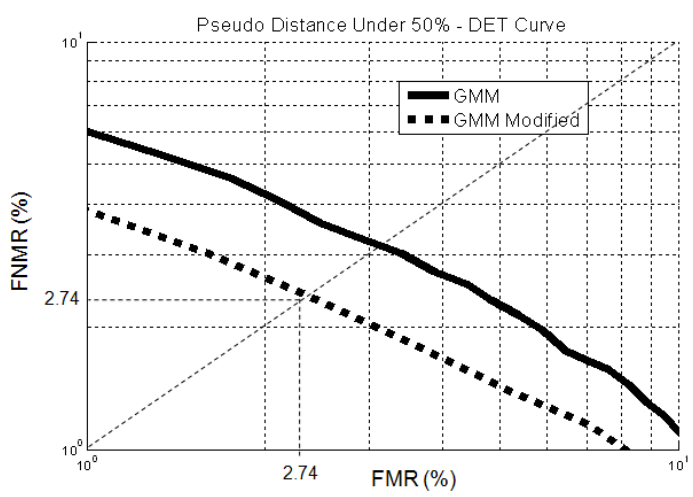
Figure 2. DET curves of the signature verification for algorithms [16,19] (GMM Modified and GMM, respectively).